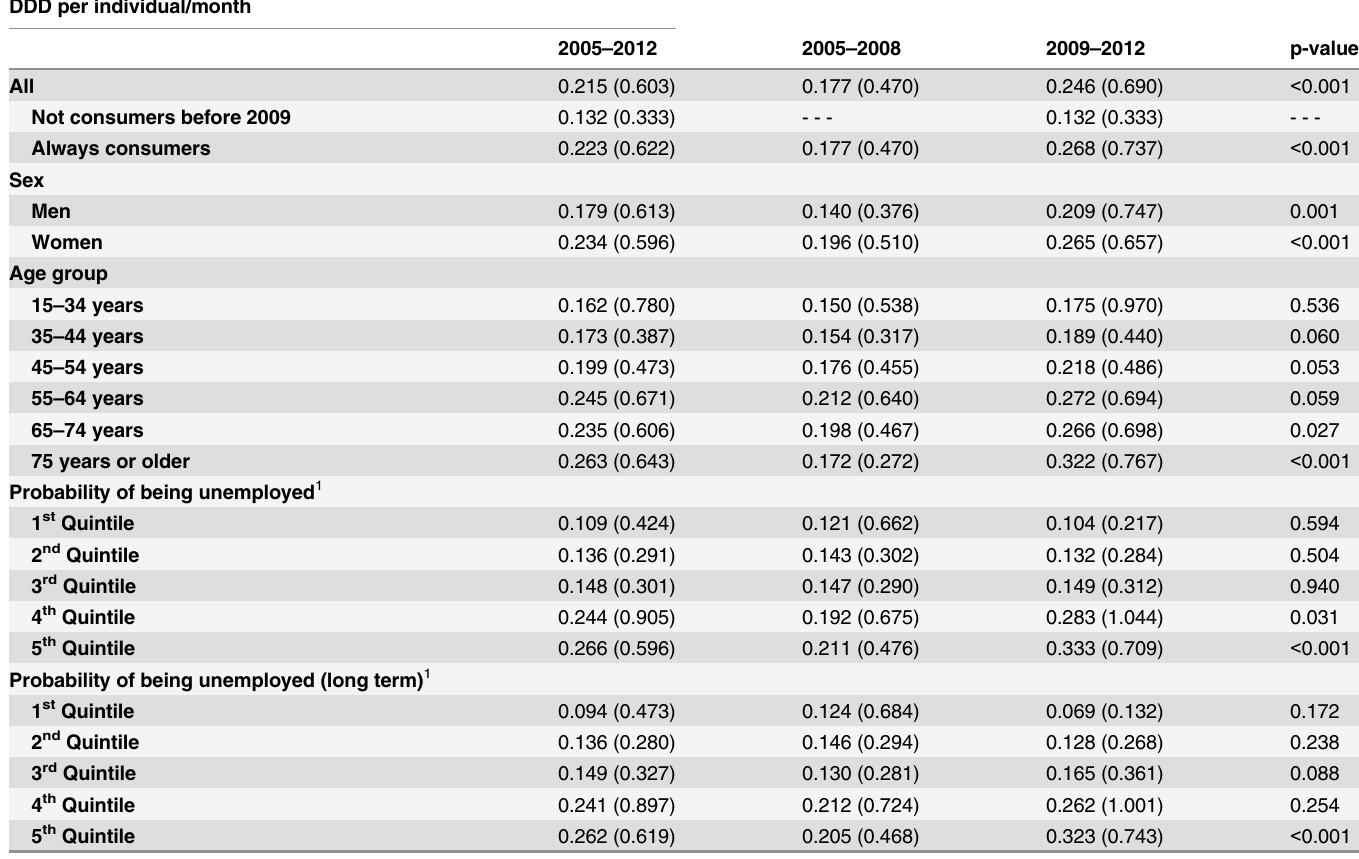
Table 3. Consumption of psychotropic drugs. DDD per